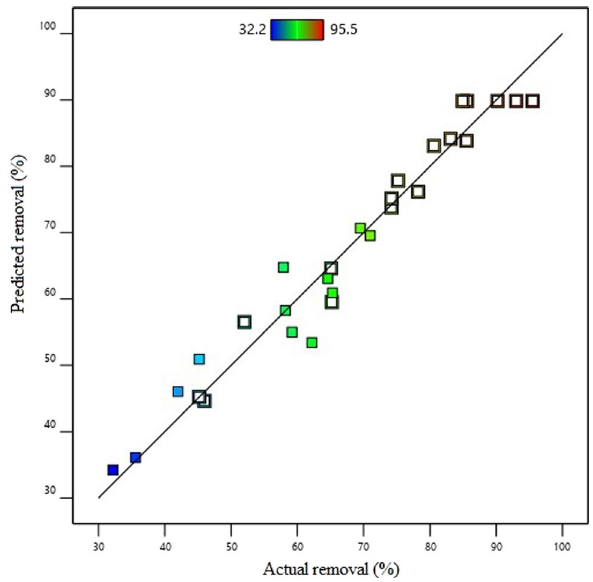
Table 5 Analysis of variance for the quadratic model of MG